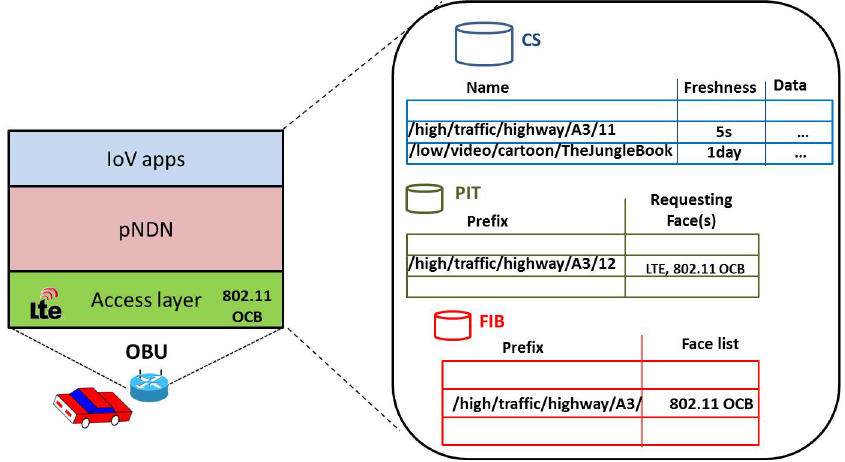
Figure 2. Protocol stack with prioritized Named Data Networking (pNDN) and supporting